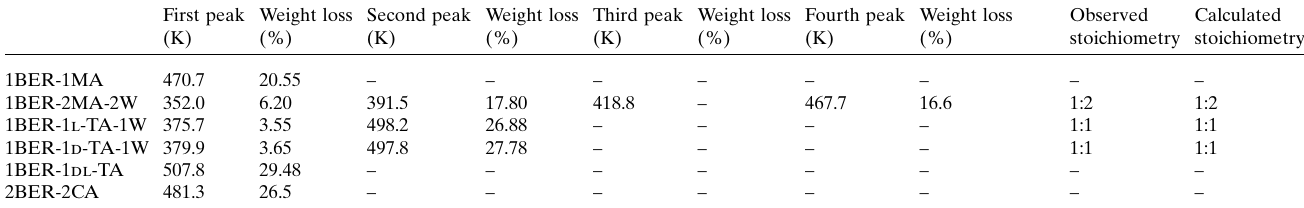
Table 3 Water molecule loss numbers and dehydration temperature of six BER salts. First peak